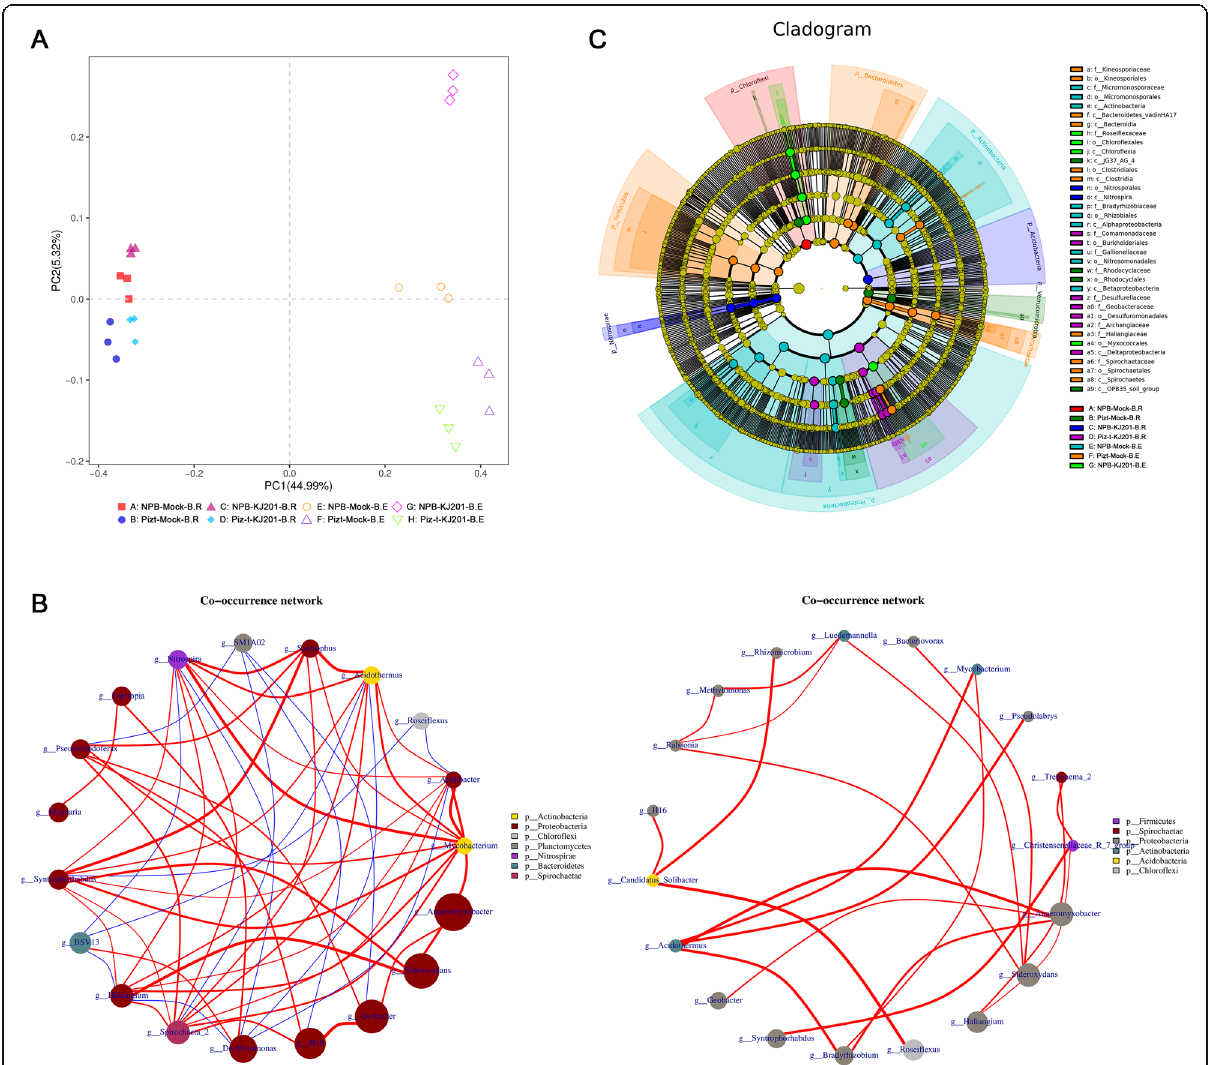
Fig. 5 Bacterial communities are separable by rhizocompartment and endocompartment. a Principal component analysis of OTUs abundance data indicates that the largest separation between rhizocompartment and endocompartment is spatial proximity to the root (PC1) and the second largest source of variation is host genotype and inoculation (PC2). b Co-occurrence networks were constructed based on correlation analysis of taxonomic profiles. Connections were drawn between nodes that were significantly ( P < 0.01; Spearman ’ s rank correlation test) and highly correlated. The size and color of each node were proportional to the number of connections and module of the microbe, respectively. The colors of the links were mapping to the correlation (Red: positive correlation; Blue: negative correlation). c Cladogram indicating the phylogenetic distribution of fungal lineages associated with the rhizospheric and entospheric communities. The circles from inside to outside indicate bacterial taxonomic levels from phylum to genus. Each small circle at each classification level represents a classification at that level, and each circle ’ s diameter is proportional to the taxon ’ s abundance. Yellow dots represent bacteria not significantly varying in abundance among treatments. Biomarker fungi are coloured according to their correspondingly class colors on the right. Red nodes represent thebacterial taxa that play an important role in the red group, the green nodes represent the bacterial taxa that play an important role in the green group, which is applicable to the other circles. The names of the species in English letters are shown in the illustration on the